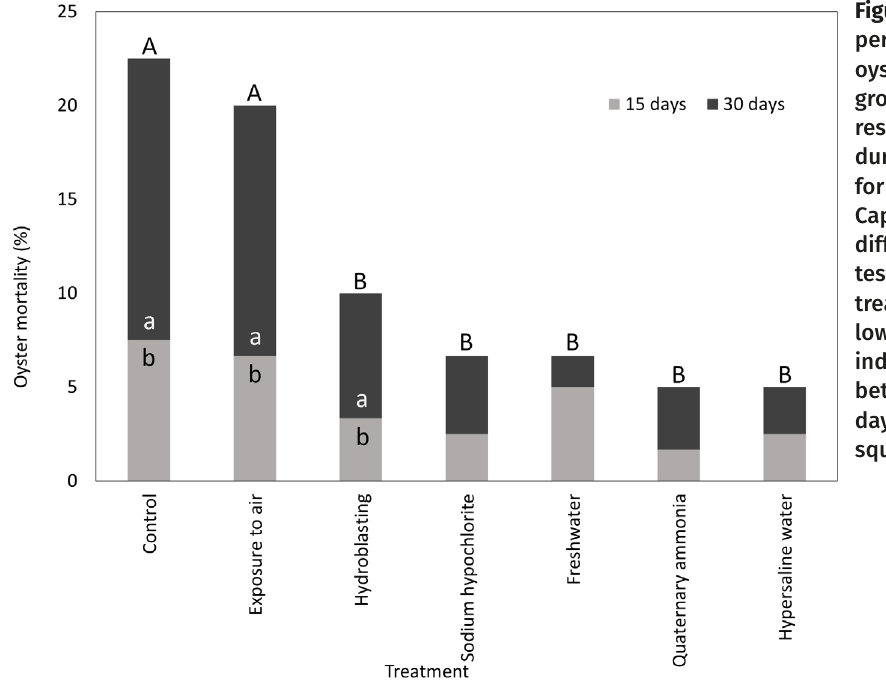
Figure 4. Cumulative percentage of dead oysters in the control group and in the respective treatments during the experiment for epibiont control. Capital letters indicate differences (Duncan test; p<0.05) among treatments and lowercase letters indicate differences between 15 and 30 days (McNemar Chi - square test;